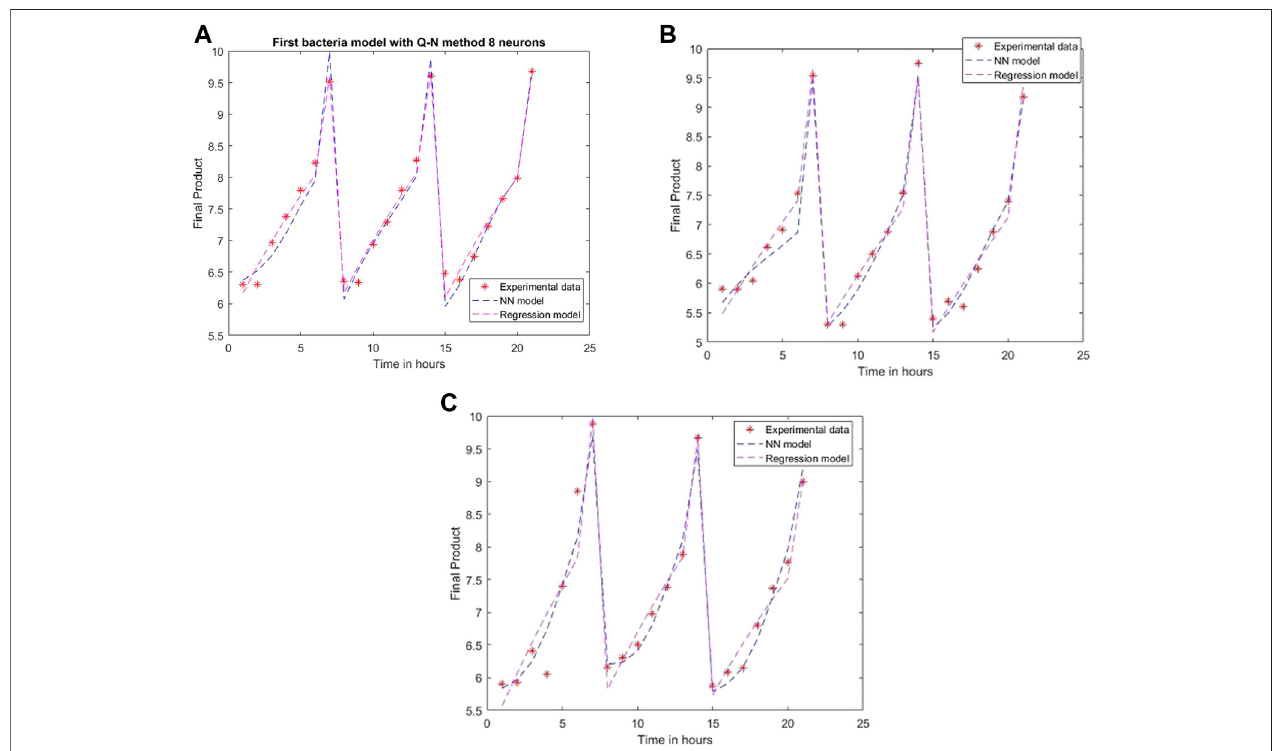
FIGURE 9 | Model results with the Quasi-Newton method and eight neurons for (A) L. plantarum ; (B) L. casei ; (C) co-cultures of L. plantarum and L. casei .